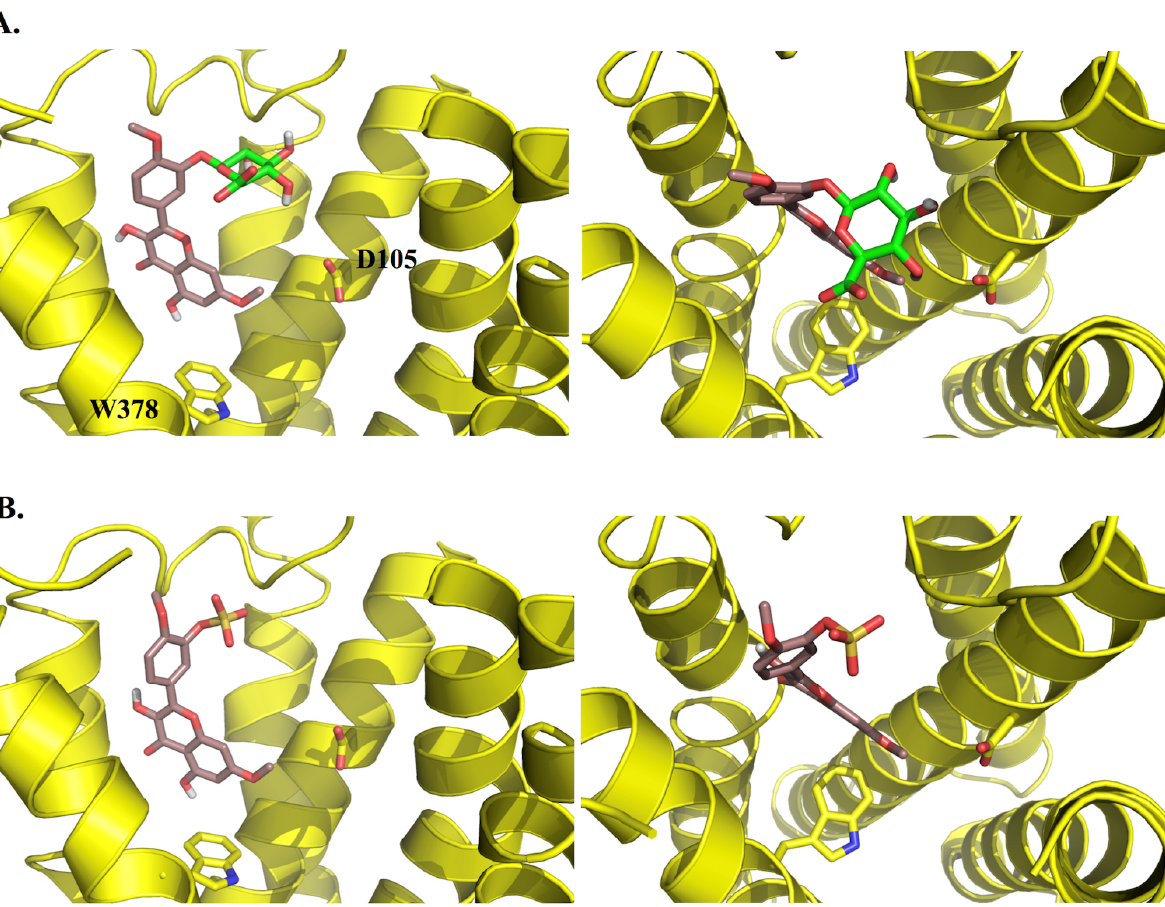
Figure 6. 3D representations of the docking poses of ( A ) ombuin-3'-glucuronide and ( B ) ombuin-3'-sulfate in complex with the human M mAChR model obtained from 1 induced-fit docking using Glide v5.7 and Prime v3.0 (Schrödinger LLC) with side views and top views (from the extracellular surface) depicted in the left hand and right hand panels, respectively. For the purpose of clarity, only D105 and W378 from among the active site residues are depicted in stick representation and some of the transmembrane helices are not shown. The carbon atoms of the glucuronide moiety in ombuin-3'-glucuronide are coloured in light